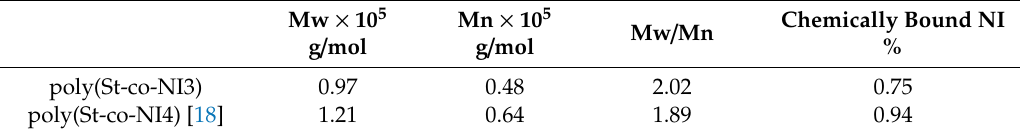
Table 1. Molecular characteristics of copolymers.